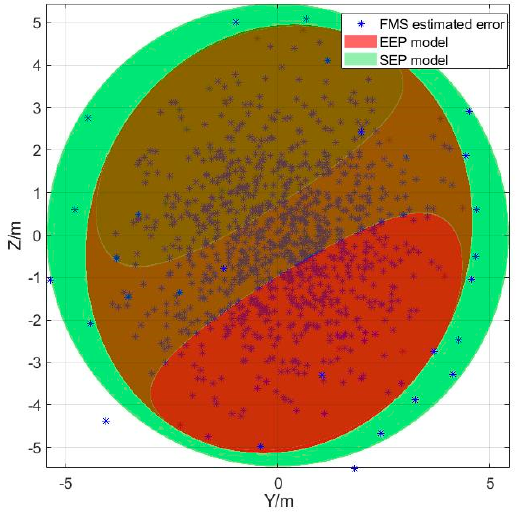
Figure 9. Comparison between EEP model and SEP model in YOZ plane. The calculation process of three-dimensional ANP evaluation method based on the EEP model is shown in Figure 10 (Algorithm